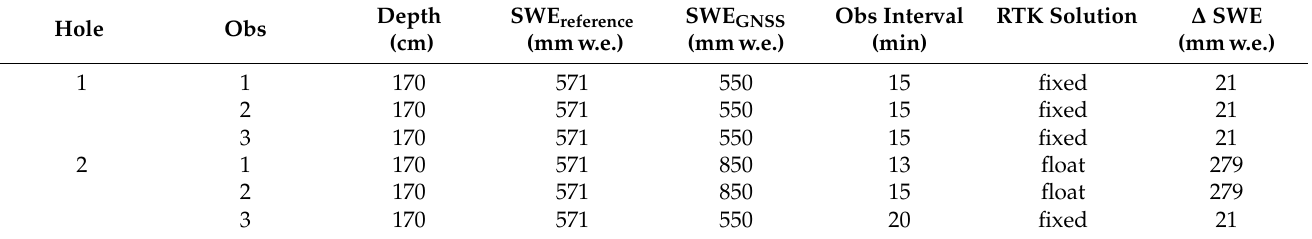
Table 4. Comparison of (near) real-time GNSS-derived SWE from the mobile, low-cost setup with the reference SWE at Davos Weissfluhjoch. Obs: